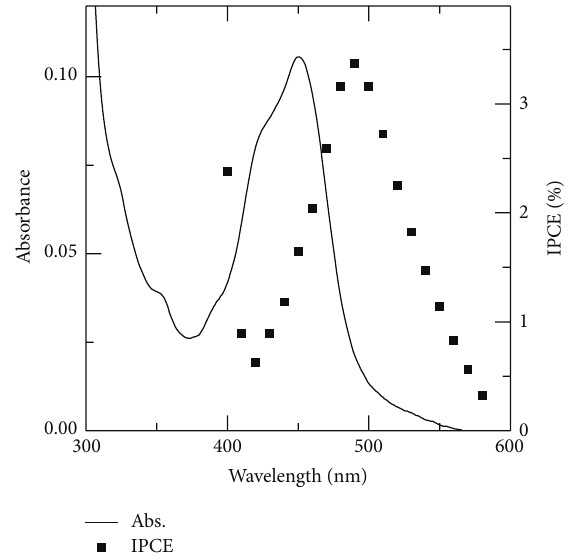
Figure 9: Plots of IPCE versus wavelength of Ru-dye/CM- 𝛽 -CD- containing device and absorption spectrum of Ru-dye (1.1 × 10 −5 M) in ethanol.